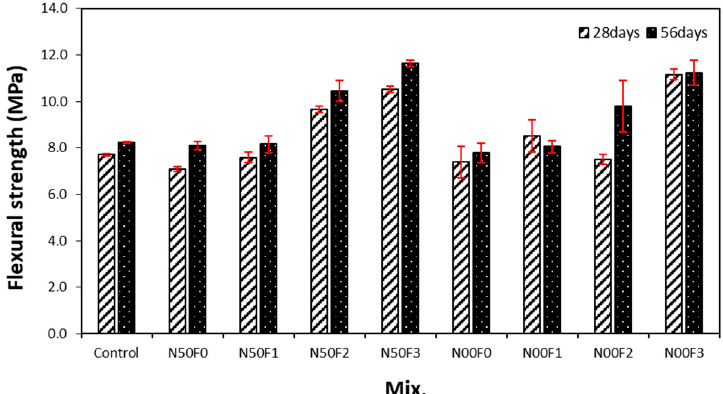
Figure 8. Flexural strengths of different mixture samples.